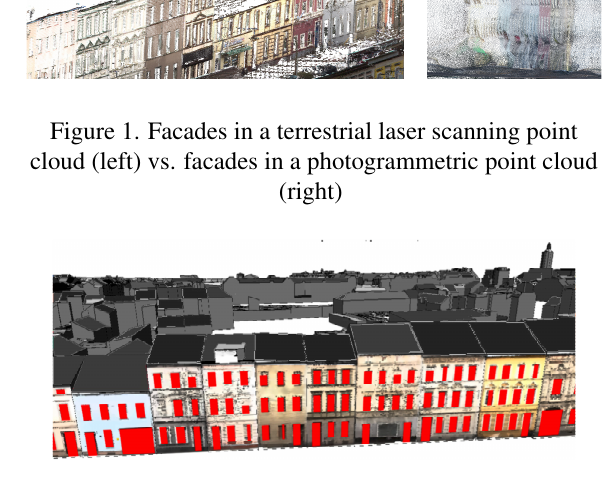
Figure 2. Detected windows and doors based on a terrestrial laser scanning point cloud in connection with a 3D city